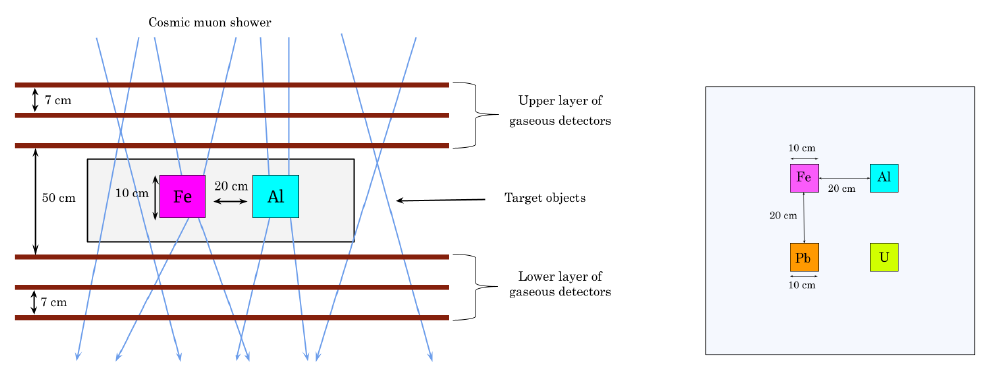
Figure 1. XZ projection ( left ) and XY projection ( right ) of simulation